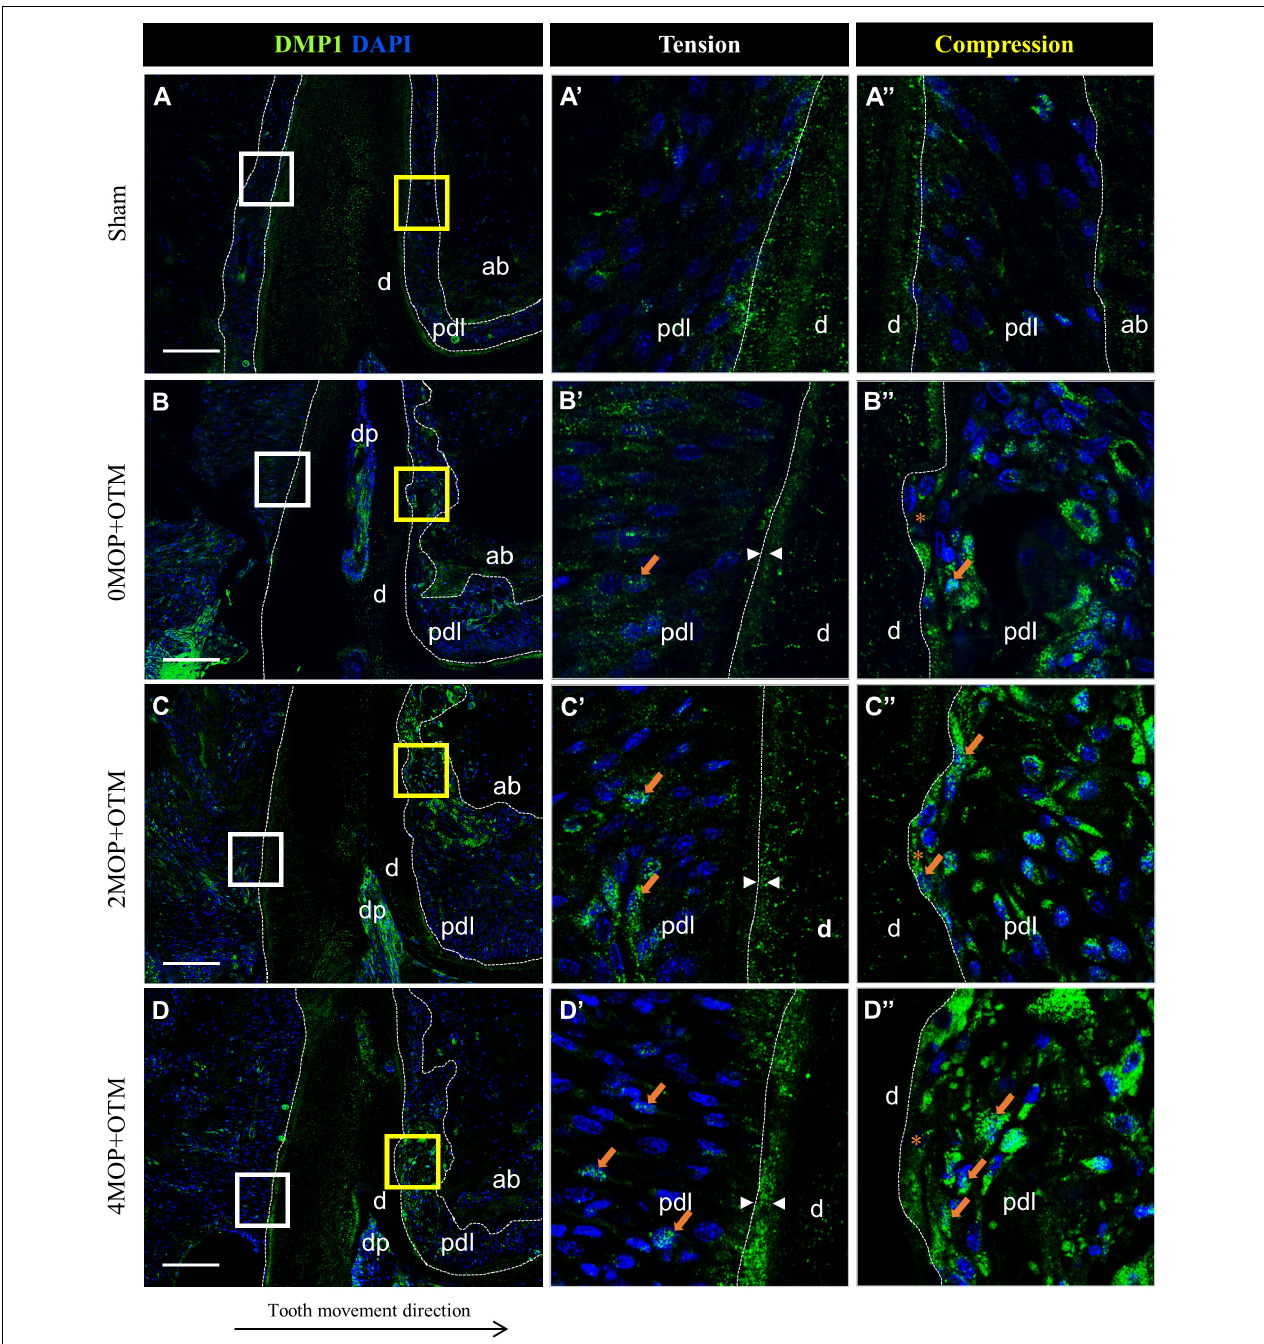
FIGURE 8 | Differential expression of DMP1 dependent to the number of MOP. (A) In Sham group, DMP1 was evenly expressed in both sides of cementum layer and PDL tissue. (A’) High magnification of tension side and (A”) Compression side PDL of the Sham group. (B) DMP1 expression in 0MOP+OTM group. (B’) Tension side and (B”) Compression side. Relatively stronger expression of DMP1 ( arrow ) was observed both side of PDL tissue and similar mineralization of cementum compared to Sham group. (C) DMP1 expression in 2MOP+OTM group. (C’) In tension side, DMP1 was observed moderate to high expression on PDL and mineralized cementum mass ( arrowhead ) than 0MOP+OTM group. (C”) In compression side ( crater ), stronger expression ( arrows ) was detected. (D) In 4MOP+OTM group, DMP1 was expressed ( arrows ) in similar both side of PDL tissue and stronger cementum mineralization ( arrowhead ) was showed in 4MOP+OTM group compare with 2MOP+OTM group. (D’) In tension side, high expression on PDL ( crater ) and intensively strong mineralization on cementum layer was observed. (D”) In compression side was detected strong expression on root resorption area. (Dashed lines, outlines of PDL area; d, dentin; p, periodontal ligament; ab, alveolar bone; dp, dental pulp; asterisks ( ∗ ) indicate root resorption area; arrow, examples of single stained cells; arrowhead, mineralization thickness of acellular cementum; Scale bars = 100 µ m).